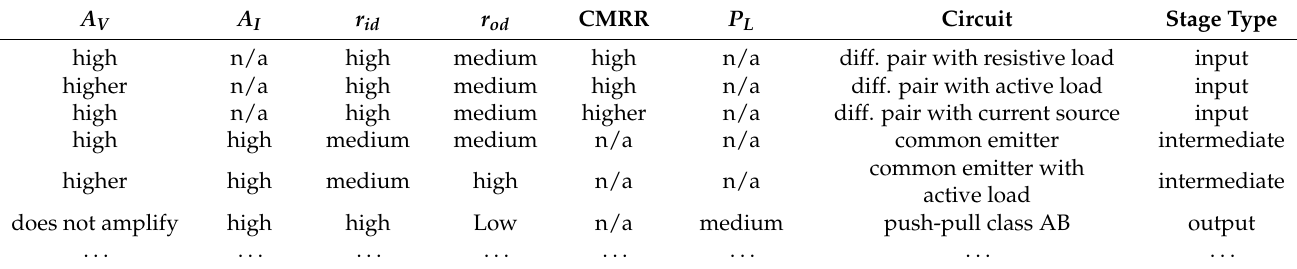
Table 2. Dataset for prediction of the stage type.